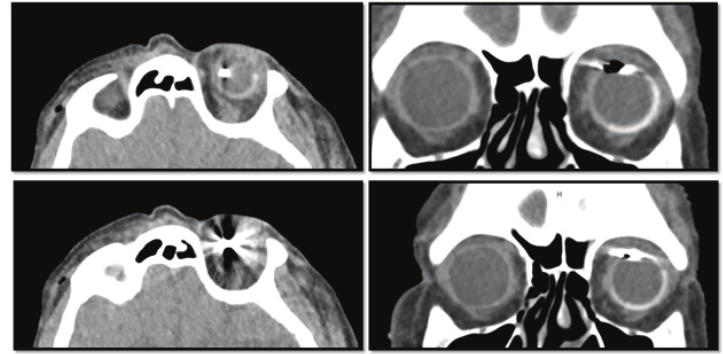
Figure 1. Orbital CT scan. Axial sections with suspected intraocular hyperdense metallic foreign body (Left panel). Large metallic foreign body with irregular borders complicated by streak artifact and air track superonasally embedding into the sclera (Right panel). CT, computed tomography.